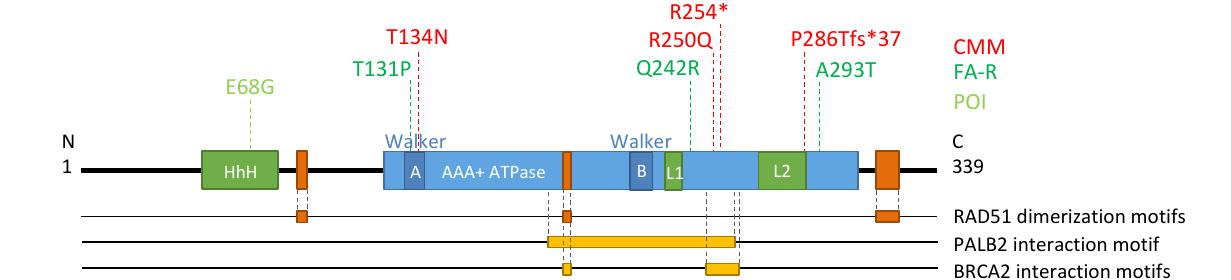
Figure 7. Human RAD51 is a 37 kDa protein (339 amino acids) with an N-terminal domain (1–84) and a C-terminal domain (89–339). The green boxes represent the DNA-binding domains: helix hairpin helix (HhH), L1 loop (L1), and L2 loop (L2). The blue box represents the AAA+ ATPase domain with Walker A and Walker B motifs (dark blue boxes), allowing for the interaction with ATP. The orange boxes represent the RAD51 dimerization motifs: the N-terminal and central motifs of two adjacent protomers interact together; the C-terminal motif (called the “ATP cap”) interacts with the ATP pocket of the adjacent protomer. The yellow boxes represent interaction motifs with the RAD51 partners: the PALB2 interaction motif overlaps with the BRCA2 interaction motifs; the most central BRCA2 interaction motif is identical to the central RAD51 dimerization motif; and the other BRCA2 interaction motif forms a secondary interface. The locations of the pathogenic variants associated with congenital mirror movement (CMM, in red), atypical Fanconi anaemia (FA-R, in dark green), and premature ovarian insufficiency (POI, in light green) are indicated.